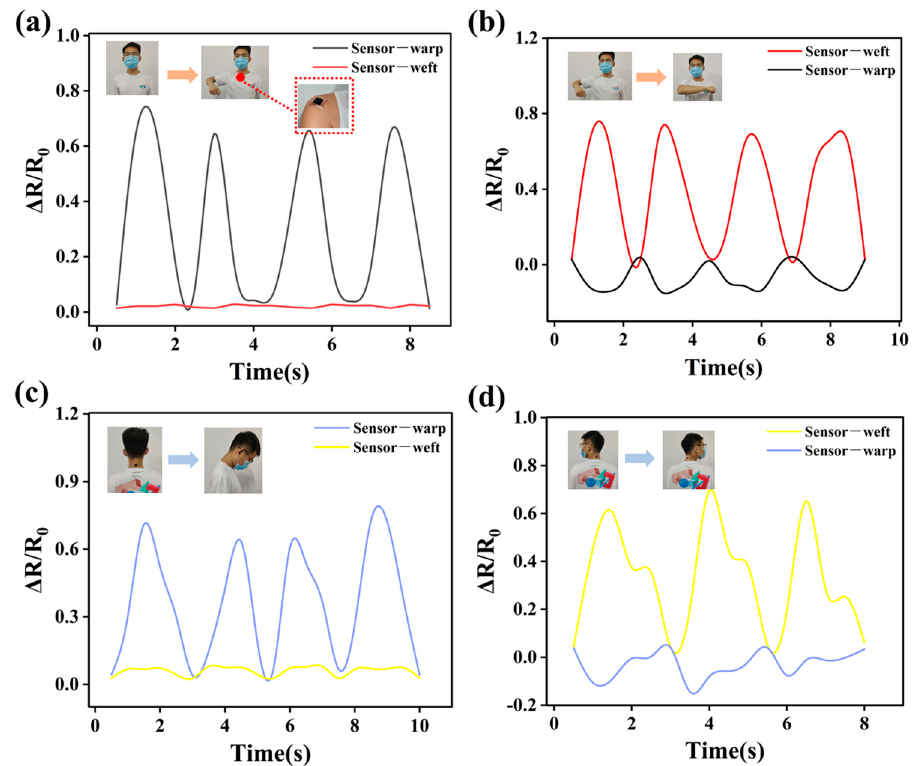
Figure 10. Applications of DEF/c-MWCNTs/PPy sensor in monitoring complicated human motions: the RRV signal of DEF/c-MWCNTs/PPy sensor in monitoring shoulder joint ( a ) up and down motions and ( b ) forth and back motions. The RRV singles of DEF/c-MWCNTs/PPy sensor in monitoring neck ( c ) up and down motions and ( d ) left and right motions.